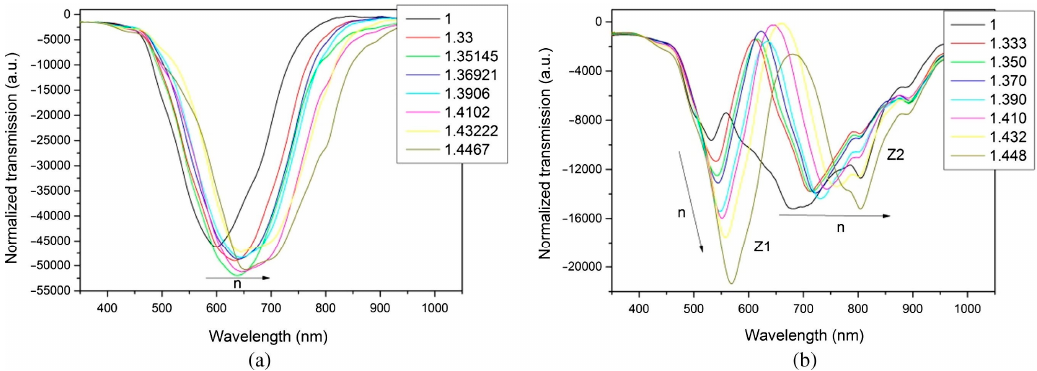
Figure 12. Transmission spectra of HfO 2 ( a ) and a ZrO 2 ( b )-coated CRMOF for different SRI. Reprinted from [10] with permission from Elsevier. Table 1. Performance of the different sensors based on the LMR detailed in this paper. A wide range of applications has been developed based on this phenomenon using a variety of materials. The sensors are sorted by coating material, configuration setup, and application.